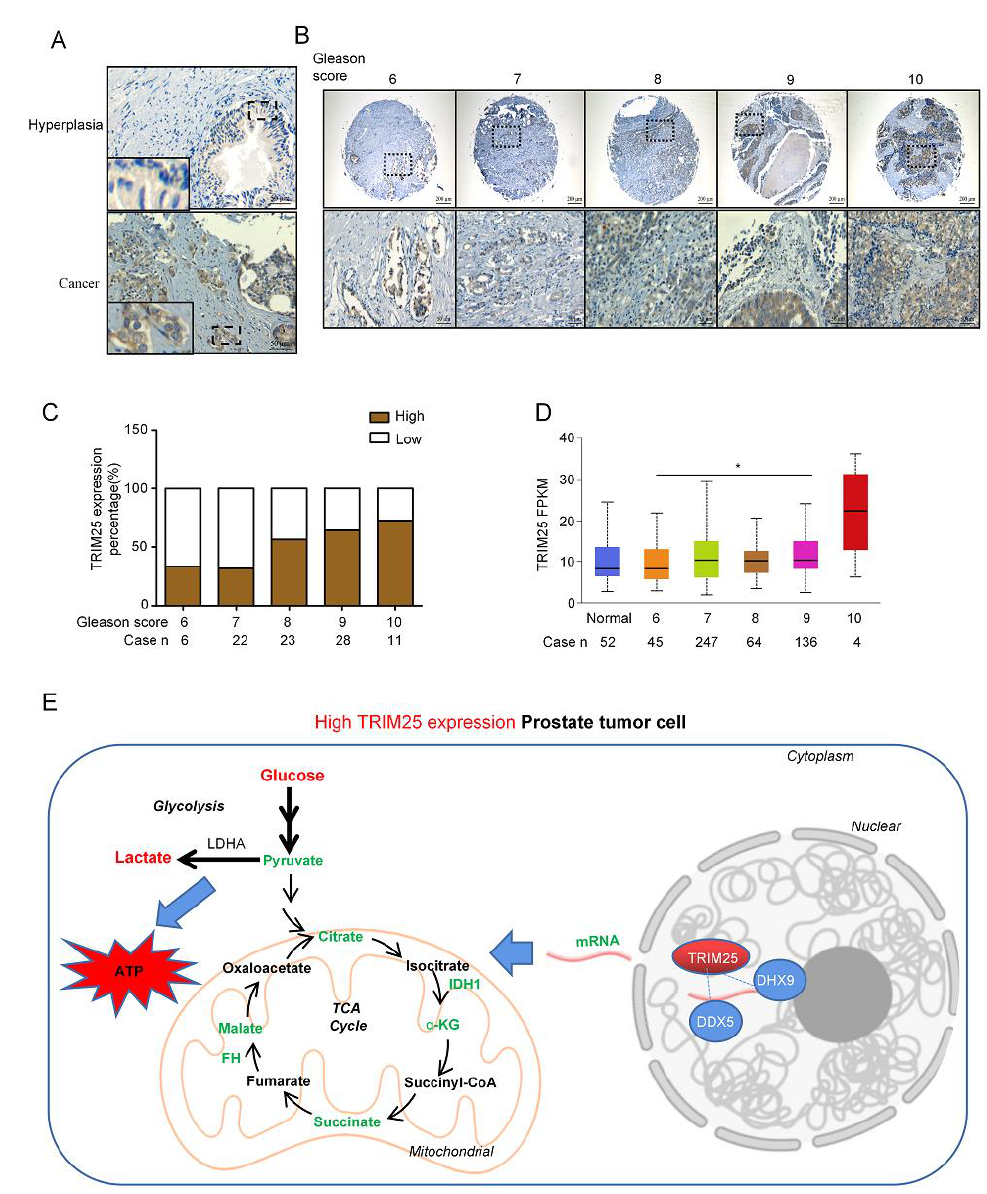
Figure 5. TRIM25 is associated with prostate cancer malignancy. ( A ) TRIM25 protein levels in prostate hyperplasia tissue and prostate cancer by immunohistochemistry. Scale bar = 50 µ m. ( B ) Images of immunohistochemical staining of TRIM25 protein levels in prostate cancer with different Gleason scores. Scale bar = 200 μm, Zoom Scale bar = 50 μm. ( C ) Statistical analysis of the proportion of TRIM25 expression in prostate cancer tissues with different Gleason scores. ( D ) Analysis of TRIM25 expression levels in PCa with different Gleason scores from the TCGA database. ( E ) Working model of high TRIM25 levels promoting prostate cancer malignancy. * p < 0.05.